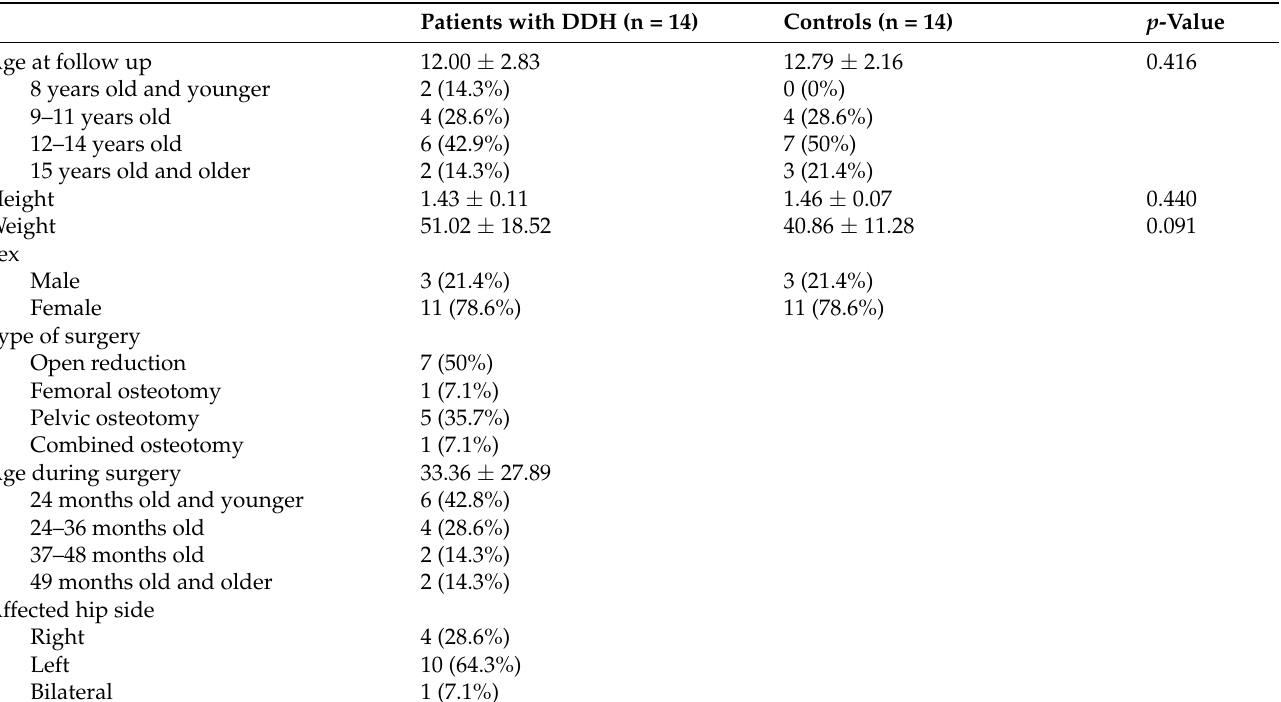
Table 1. Characteristics of the